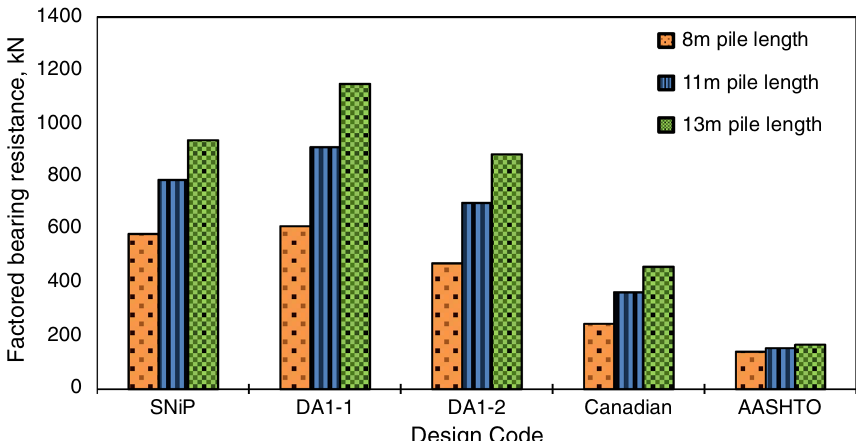
Fig. 5 Factored bearing resistance for varying pile